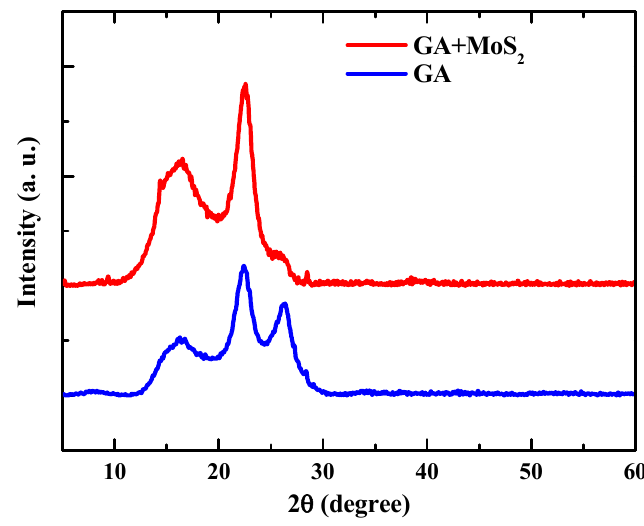
Figure 3. XRD patterns of composite graphene aerogel and pure graphene aerogel.